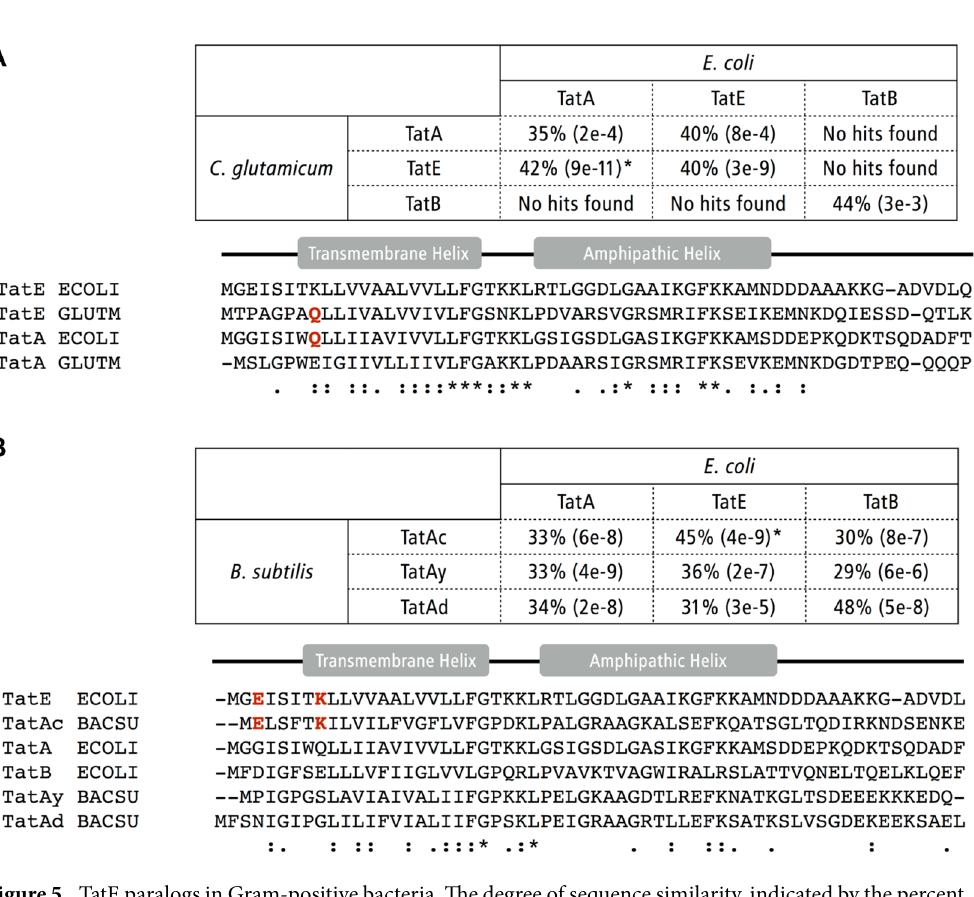
8 SCIentIfIC REpoRTs | (2018) 8:1326 | DOI:10.1038/s41598-018-19640-3